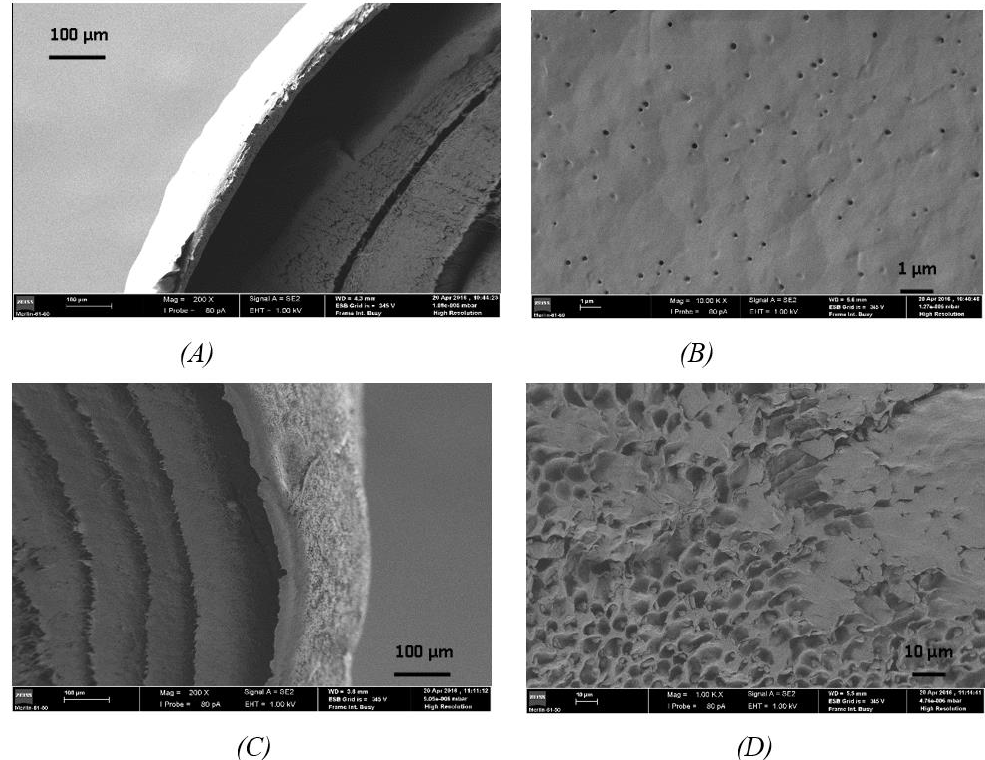
Figure 3. Images obtained by SEM. Cross-section view ( A ) and coating surface ( B ) of the MD 500 Lut implant and cross-section view ( C ) and coating surface ( D ) of the MD 500 Luw implant.